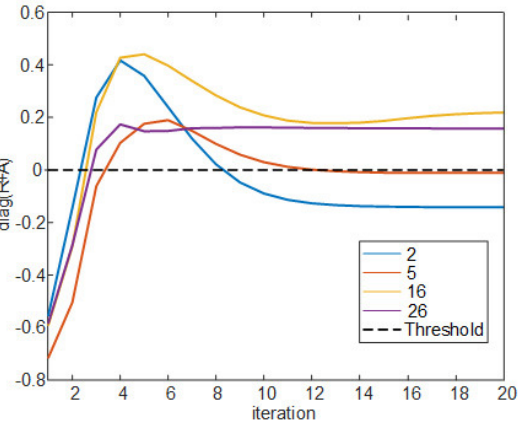
Figure 4. Diagonal component values of R + A matrix by iteration in Algorithm 1 (2, 5, 16, and 26 data points) with 0